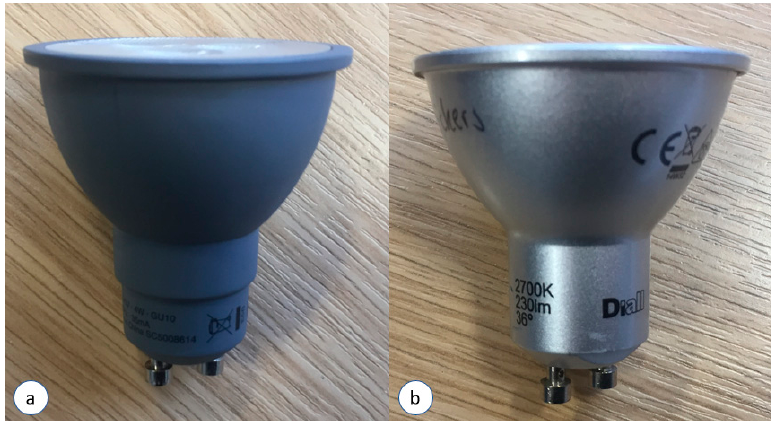
Figure 1. Two failed LED spotlights with GU10 socket. Sample A ( a ) does no longer emit any light, Sample B ( b ) flickers.